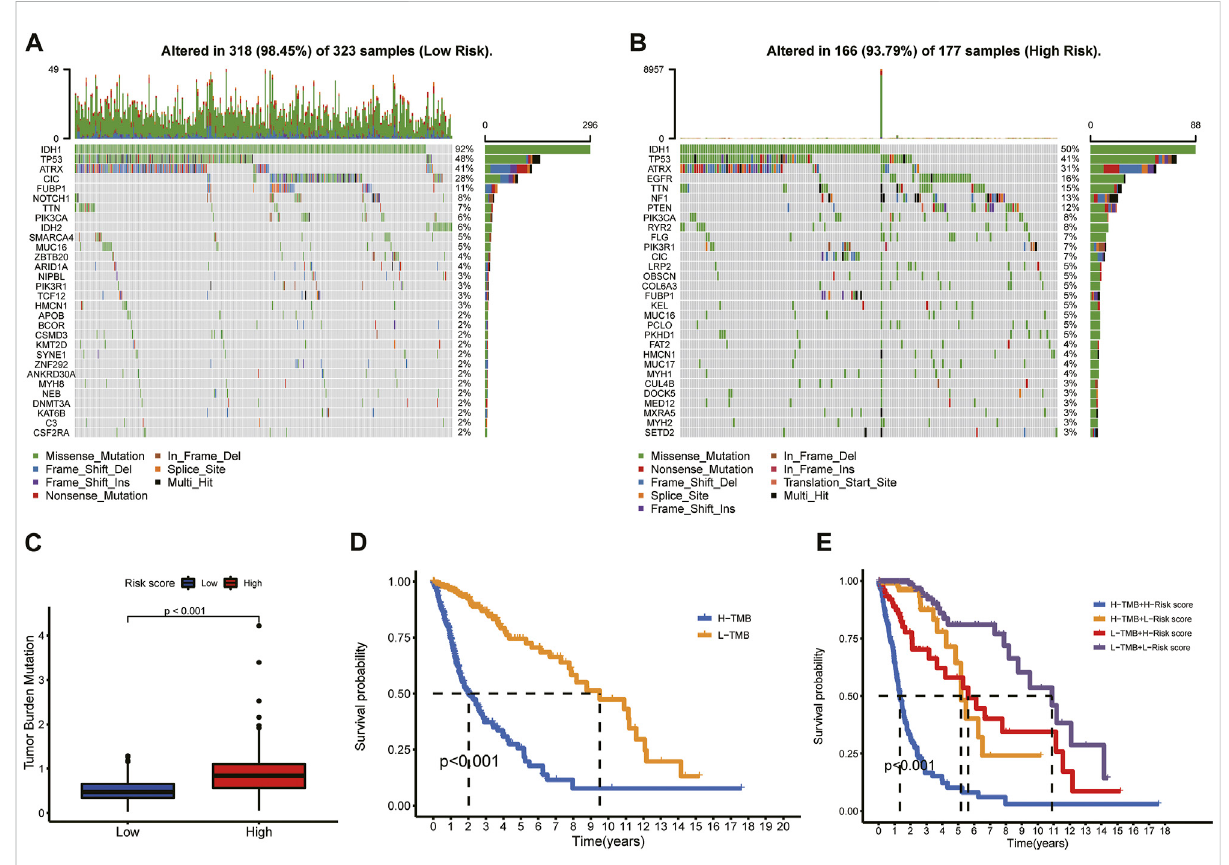
FIGURE 9 Mutational pro fi le and TMB in the low- and high-risk groups. (A) Mutational pro fi le in the low-risk group. (B) Mutational pro fi le in the high-risk group. (C) Difference in TMB between low- and high-risk groups. (D) KM analysis of the high- and low-TMB groups. (E) Survival curve of the TMB combined risk